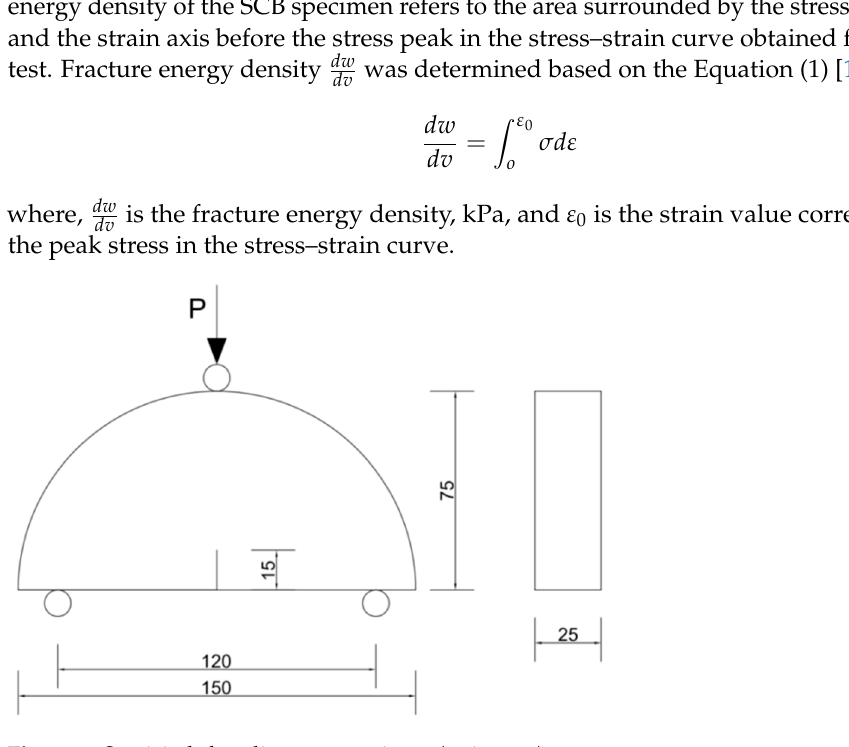
Figure 3. Semicircle bending test specimen (unit: